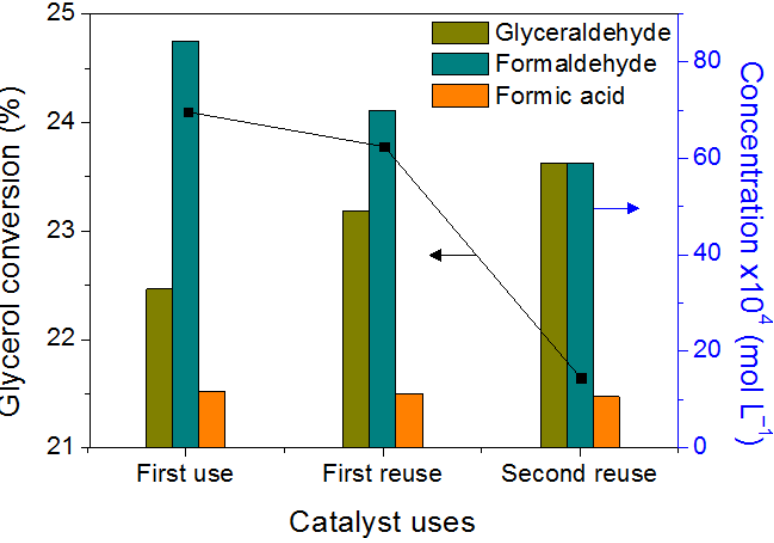
Figure 19. Glycerol degradation percentage and product concentration for different Cu/TiO 2 catalyst reuse cycles.